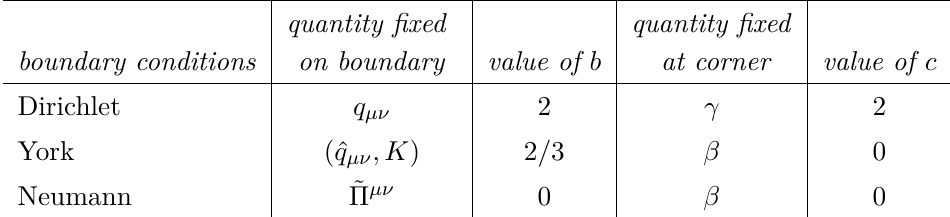
Table 3 . Different values of the energy computed as the generator of time-diffeomorphisms at conservative boundaries. A feature that inevitably catches the eye is that choosing boundary conditions with fewer components of the induced metric fixed, and more components of the momentum fixed, produces a smaller value of the energy for time-like boundaries with positive extrinsic curvature, as in the Kerr example. One may speculate an interpretation for this by saying that holding the momenta fixed at the boundary instead of the configuration variables, energy is being stored there and removed from the